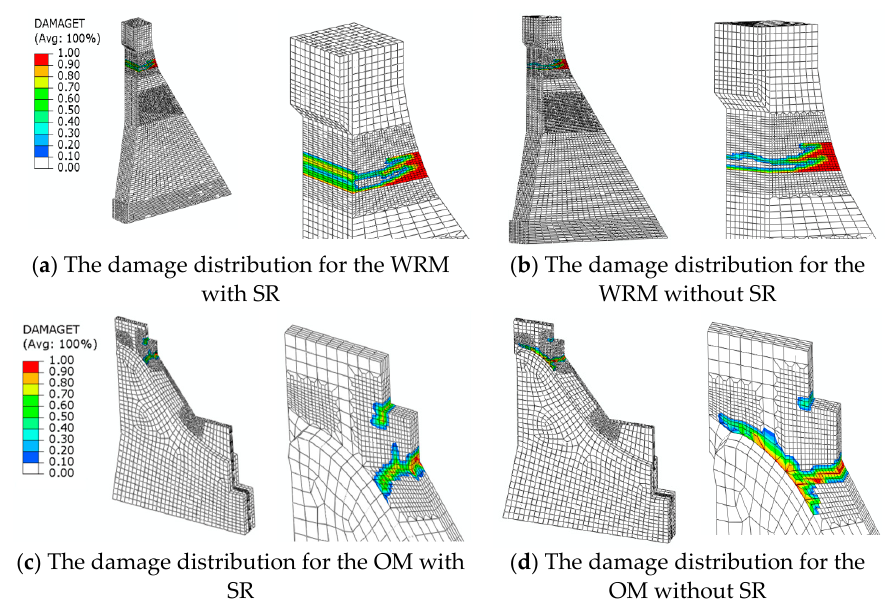
Figure 13. The damage distribution for the prototype numerical model.